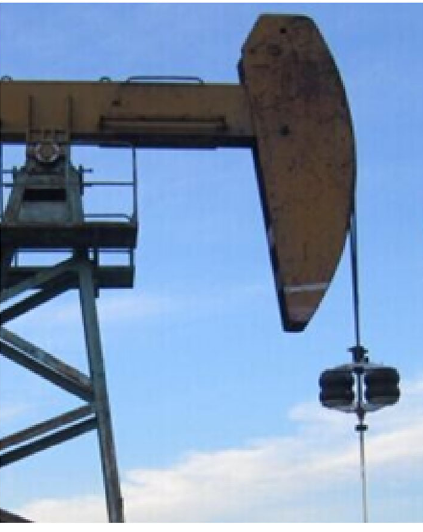
Fig. 2 Shock absorber with pneumatic spring (Lu